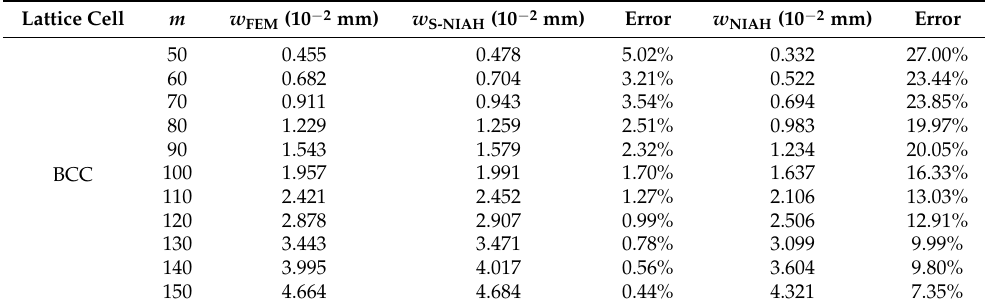
Table 9. Average values of node deflection at mid-point of cylinder w FEM , deflection values considering equivalent shear stiffness w S-NIAH , and deflection values without considering equivalent shear stiffness w NIAH under different m.